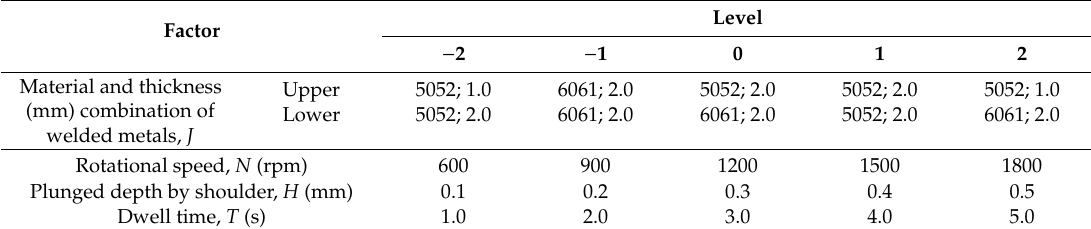
Table 4. FSSW process factors and their feasible range adopted in this investigation.